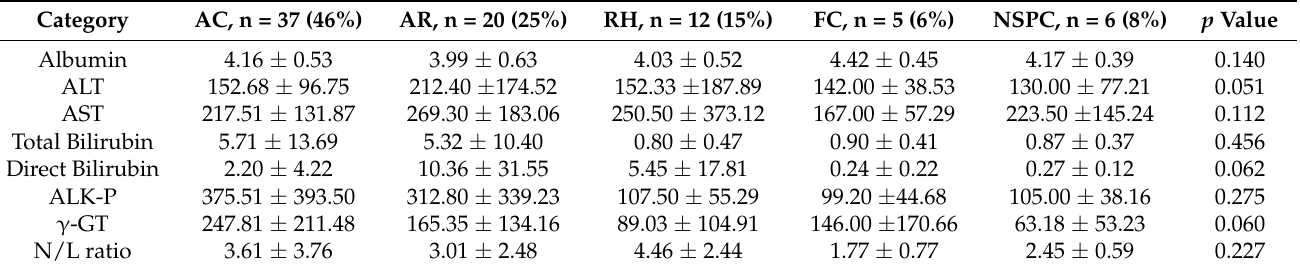
Table 2. Clinical biochemistry data in different liver graft pathologies after living donor liver trans- plantation.